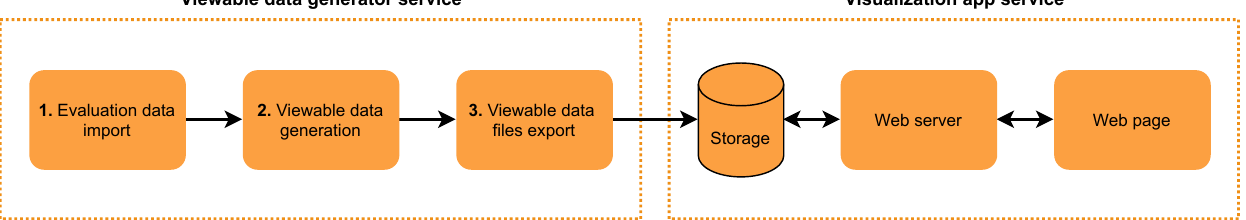
Figure 6. The conceptual diagram of the iBikeSafe visualization